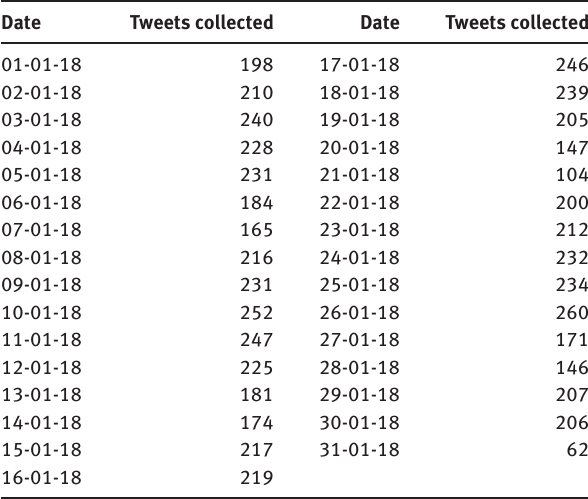
Table 1: Daily Tweet collection.